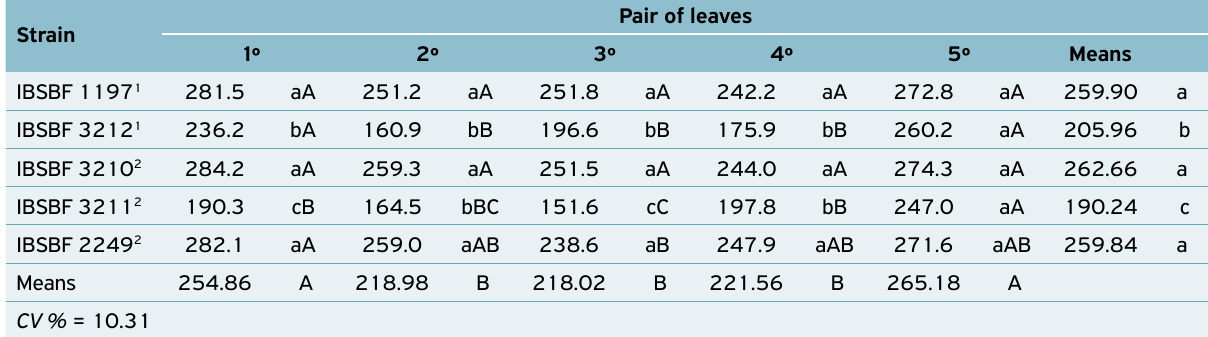
Table 2. Area under the disease progress curve (AUDPC) of five pairs of leaves of Catuaí Vermelho IAC 81 coffee cultivar, inoculated with Pseudomonas syringae patovars garcae and tabaci . Strain